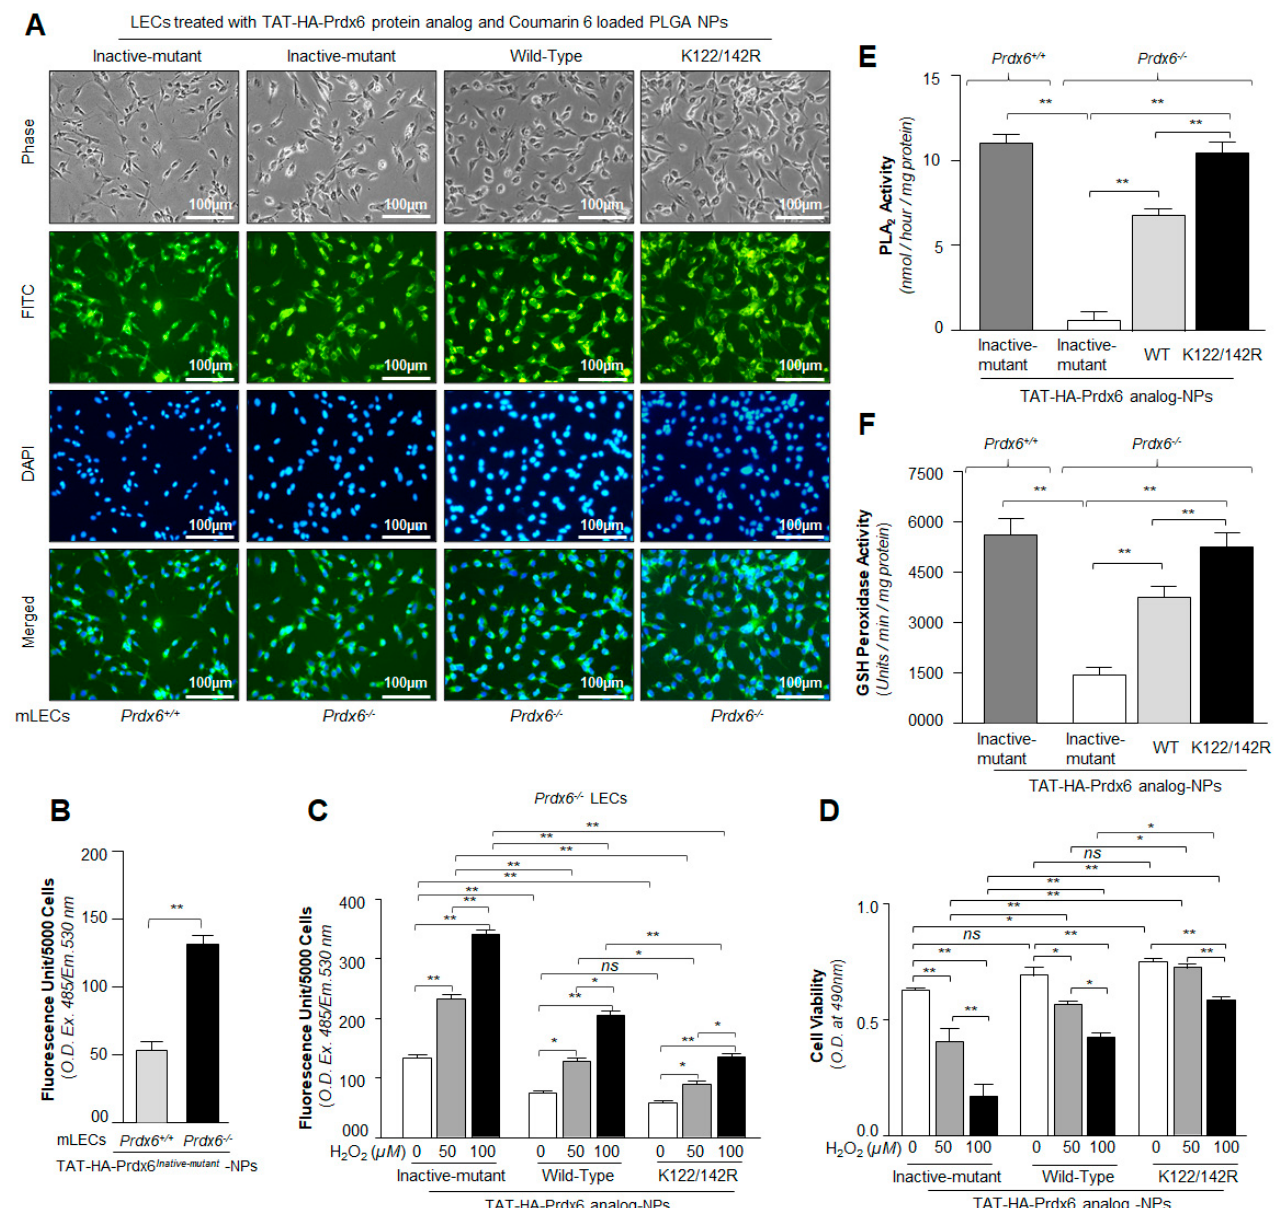
Figure 5. ( A ) Photomicrographs showing cellular internalization of TAT-HA-Prdx6 protein analog-loaded NPs along with Coumarin-6 into Prdx6 +/+ mLECs and redox-active (a model for aging) Prdx6 − / − mLECs. Prdx6 +/+ and Prdx6 − / − mLECs were incubated with TAT-HA-Prdx6 analog-NPs with Coumarin-6 for 6 h; then, cells were tryspinized and cultured on glass coverslips for taking photomicrograph. Fluorescence and DAPI staining images of cells were recorded after 24 h under inverted fluorescence microscope (Nikon Eclipse Ti-U) as shown. ( B ) Prdx6-deficinet ( Prdx6 − / − ) LECs displayed significantly increased levels of ROS compared to Prdx6 +/+ incubated with TAT-HA-Prdx6 Inactive-mutant -NPs. Histogram values represents the mean ± SD from three independent experiments. Prdx6 +/+ vs. Prdx6 − / − , (** p < 0.001). ( C , D ) Increased protective activity of Sumoylation-deficient TAT-HA-Prdx6 K122/142R -NPs compared to TAT-HA-Prdx6 WT -NPs. Prdx6 analog-NPs-treated Prdx6 − / − LECs were exposed to different concentrations of H 2 O 2 as indicated in the figure. After 8 h, ROS levels were assessed with H2-DCF-DA dye assay ( C ), and viability of cells was assessed by MTS assay at 48 h of H 2 O 2 exposure ( D ). Histogram values represent the mean ± SD from three independent experiments. TAT-HA-Prdx6 Inactive-mutant -NPs vs. TAT-HA-Prdx6 WT -NPs and TAT-HA-Prdx6 K122/142R -NPs; TAT-HA-Prdx6 WT -NPs vs. TAT-HA-Prdx6 K122/142R -NPs (* p < 0.05, ** p < 0.001). ( E , F ) Mutation at Sumoylation sites, K122/142R in Prdx6 augmented aiPLA 2 and GSH peroxidase activities. mLECs were treated with Prdx6 analog-NPs as shown. Then, 48 h later, a total cell lysate of each sample having equal amounts of protein was prepared and processed for PLA 2 and GSH peroxidase activities by PLA 2 and GSH peroxidase assay kits (Invitrogen). Prdx6-deficient LECs showed significantly low levels of PLA 2 as well as GSH peroxidase activities